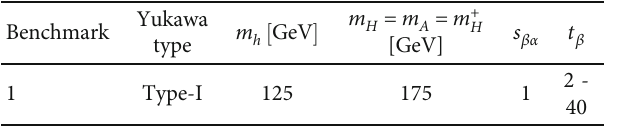
Figure 2: The plot between soft symmetry breaking term versus tan β . The region under bounded curves shows the theoretical constraints obeyed. Table 1: The range of independent parameters calculated within type-1